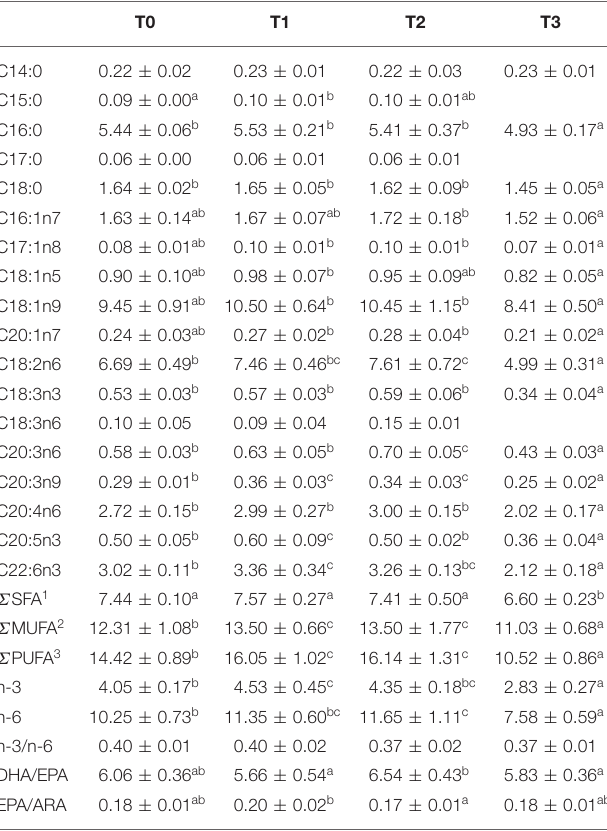
In the same line, different lower-case letters indicate significant differences (P < 0.05), values with no letter mean no significant difference (P > 0.05); 1. saturated fatty acid; 2. mono-unsaturated fatty acids; 3. poly-unsaturated fatty